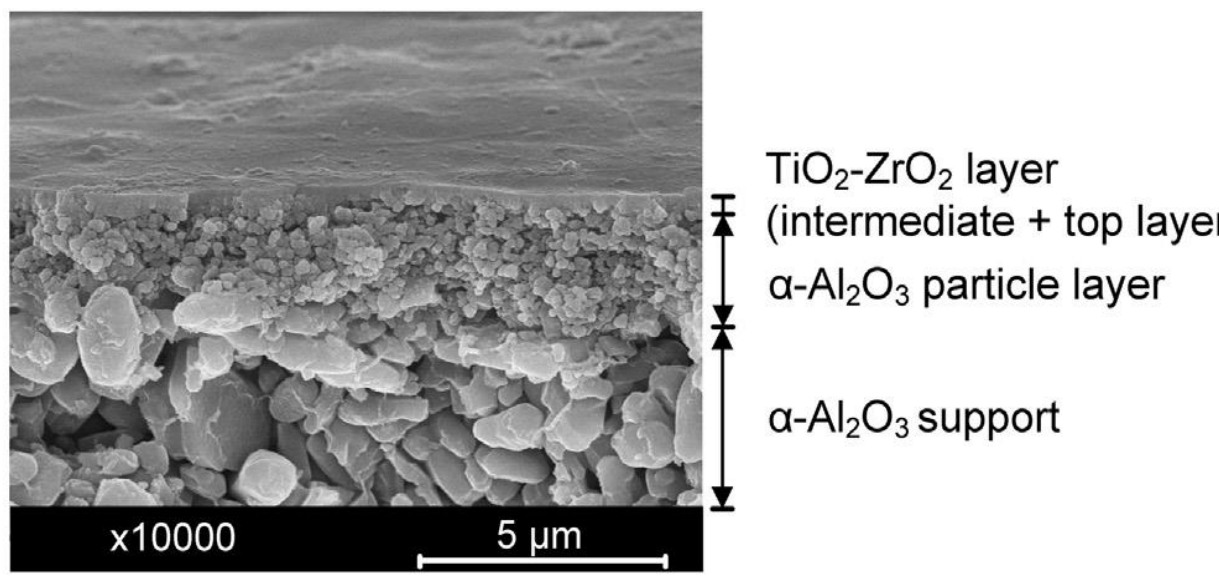
Figure 4. Scanning electron microscopy image of the cross-section of a TiO 2 -ZrO 2 inorganic–inorganic composite membrane. Reproduced from [51].